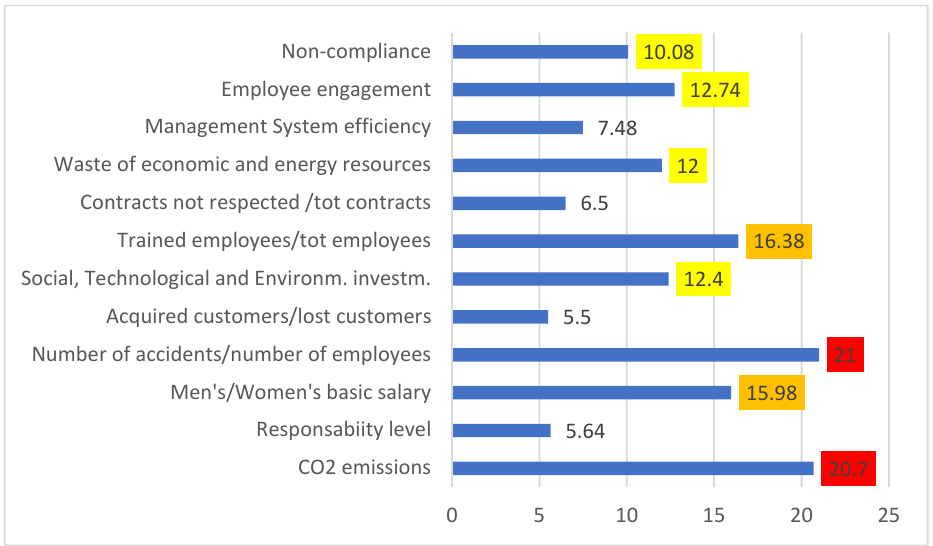
Figure 5. Process Performance (the colors order yellow-orange-red means an increasing GPI value and consequently a decreasing Performance value, Table 1).